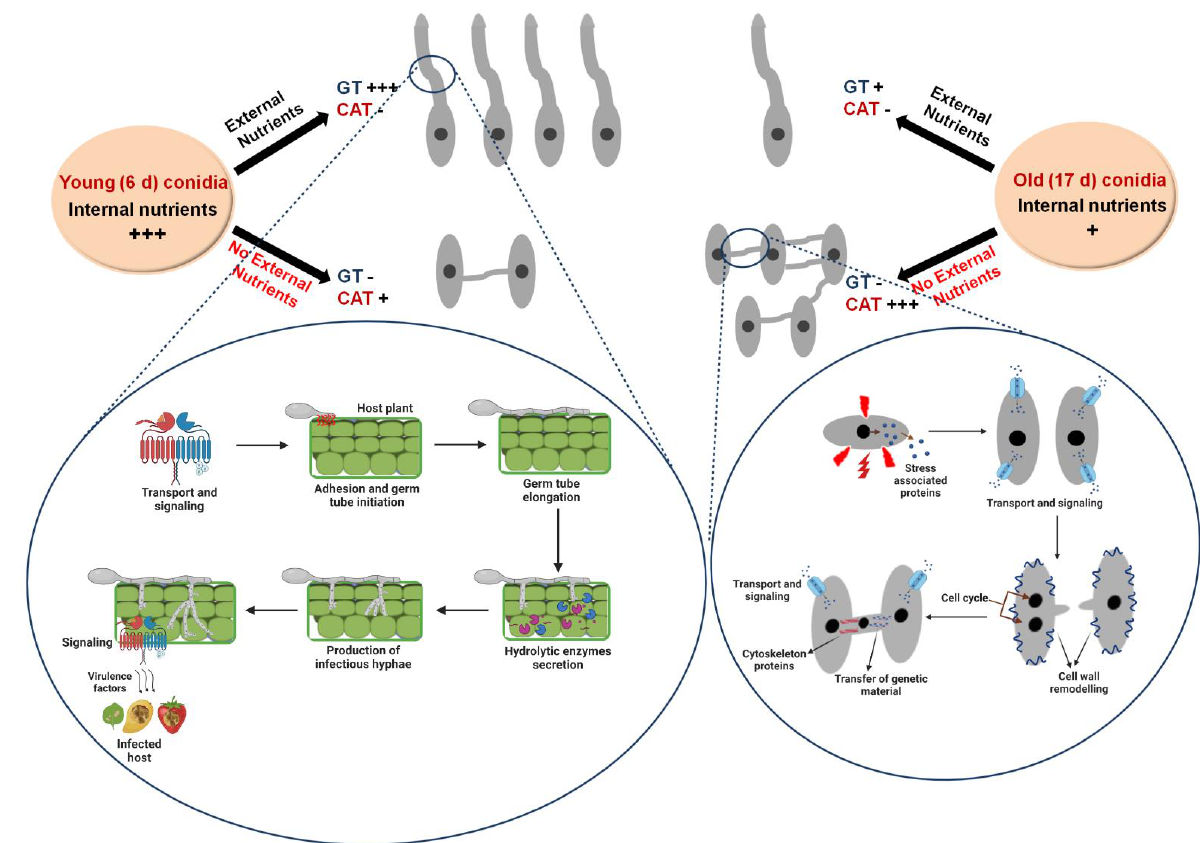
Figure 7. Model representing the differential physiological and molecular requirements of GT formation and CAT fusion in C. gloeosporioides (Model created with BioRender.com).